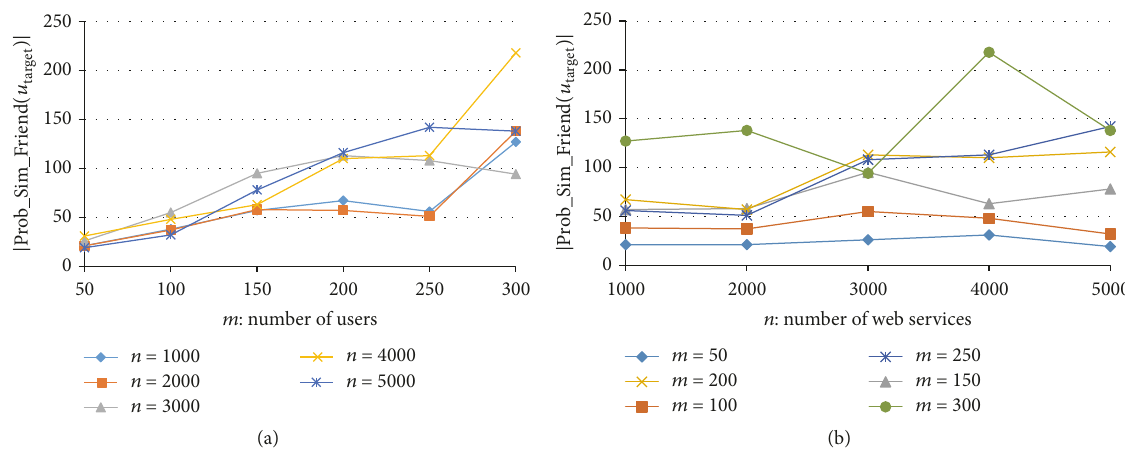
)| with respect to 𝑚 and 𝑛 target